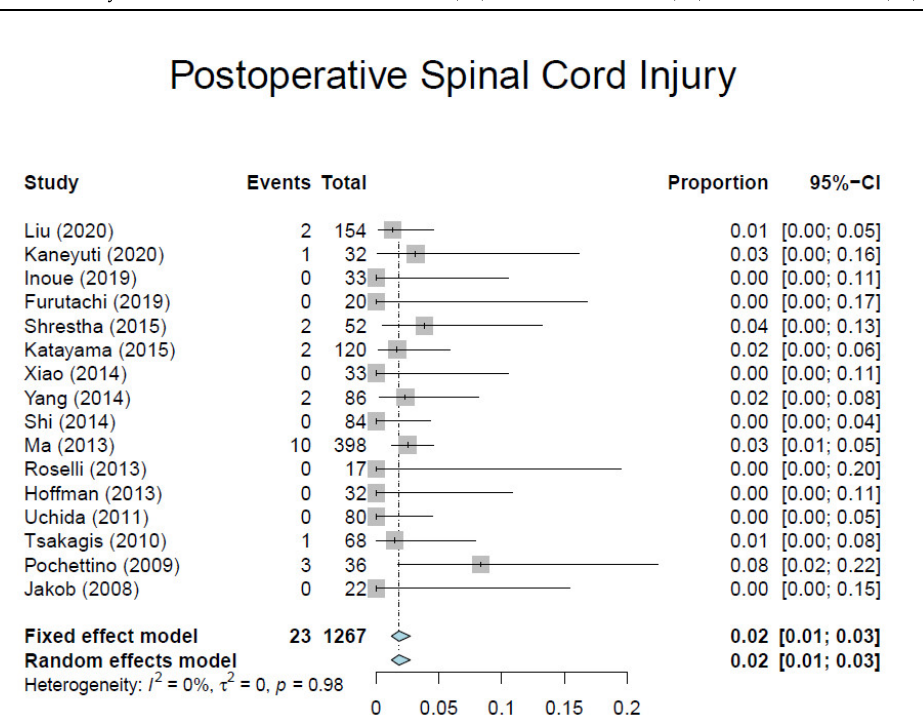
Figure 5. Forest plot depicting pooled estimates of spinal cord injury.